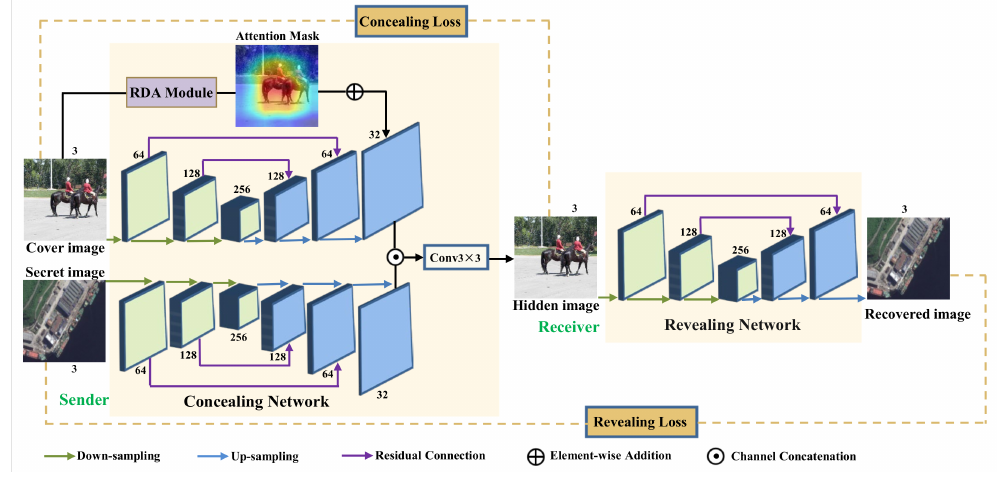
Figure 1. Overall architecture of our